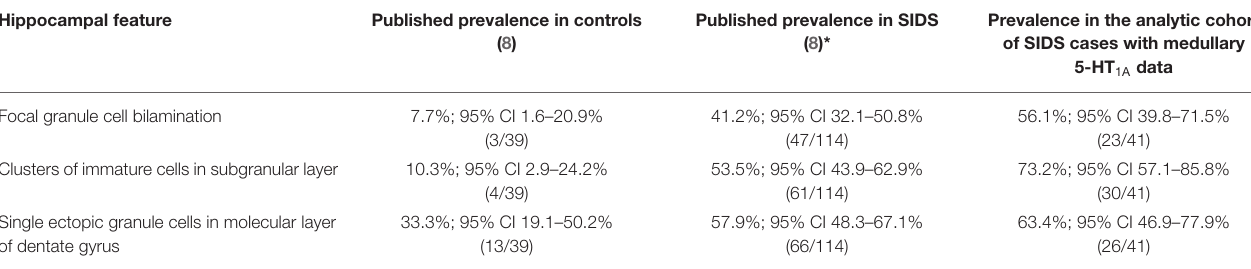
TABLE 3 | Prevalence of hippocampal features of interest in Kinney et al. (8) and their prevalence in the analytic cohort of SIDS with available medullary 5-HT 1A binding data. Hippocampal feature